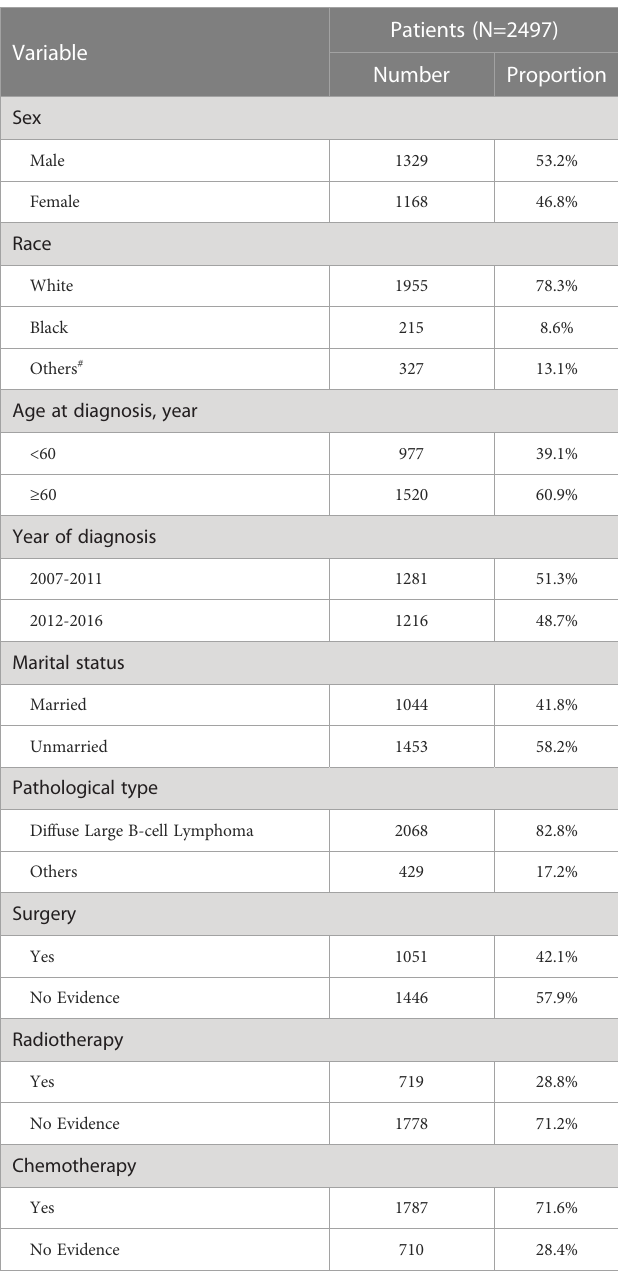
TABLE 1 Baseline